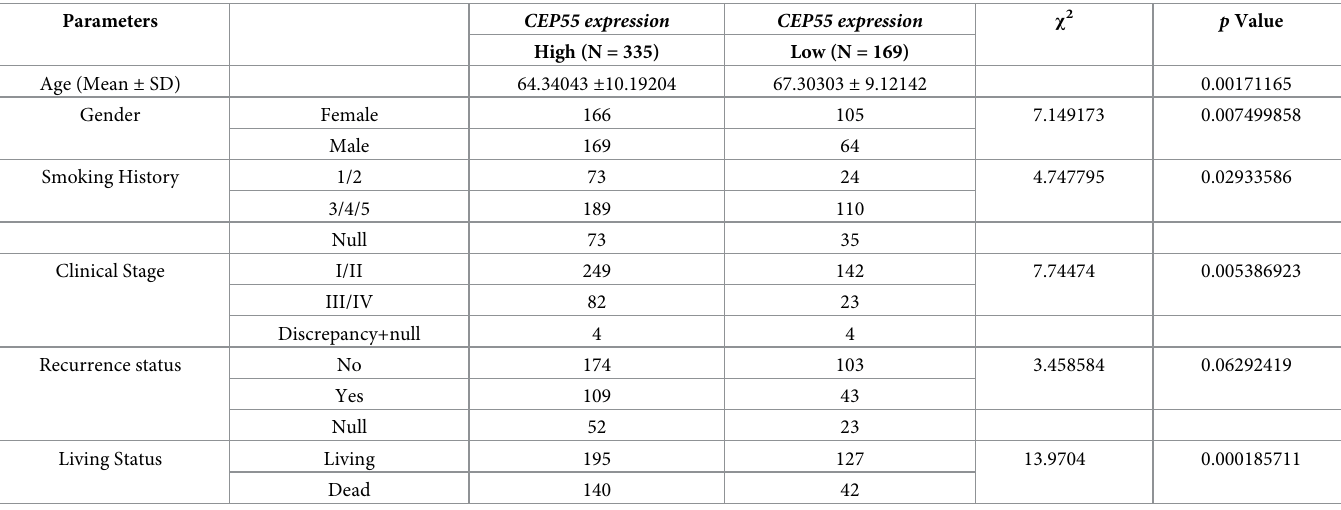
Table 1. The association between CEP55 expression and the demographic and clinicopathological parameters of patients with primary LUAD in TCGA.